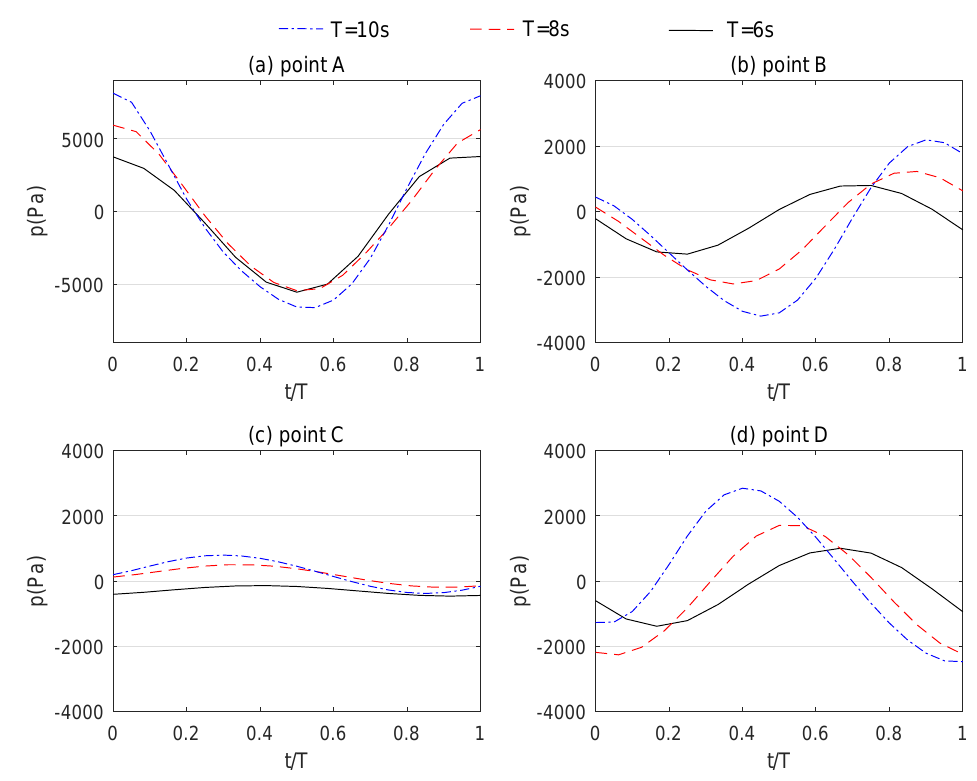
Figure 10. Distribution of the pore pressure over time in one wave cycle on four points with various wave periods.